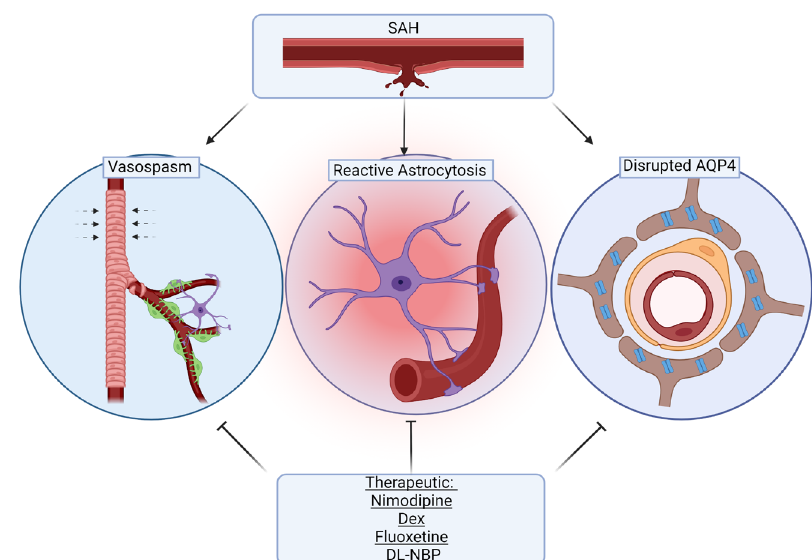
Figure 3. Broad effects of nimodipine, Dex, fluoxetine, and DL-NBP on post-SAH